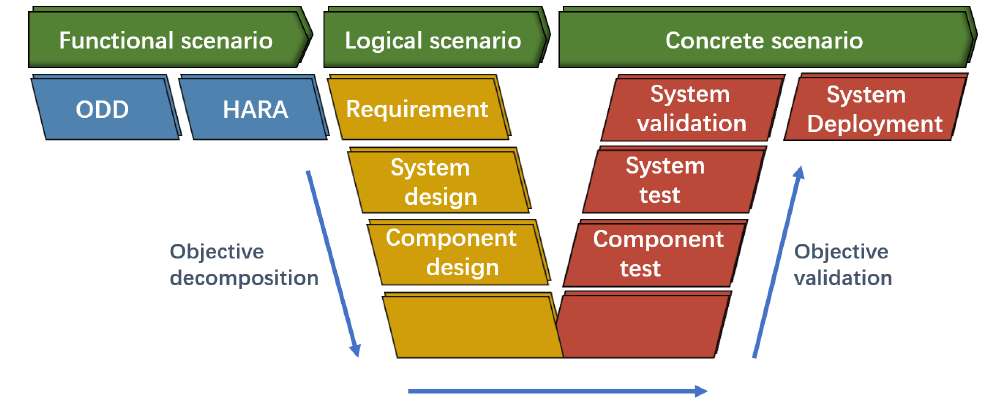
Figure 5. Functional testing scenarios during V-model-based development